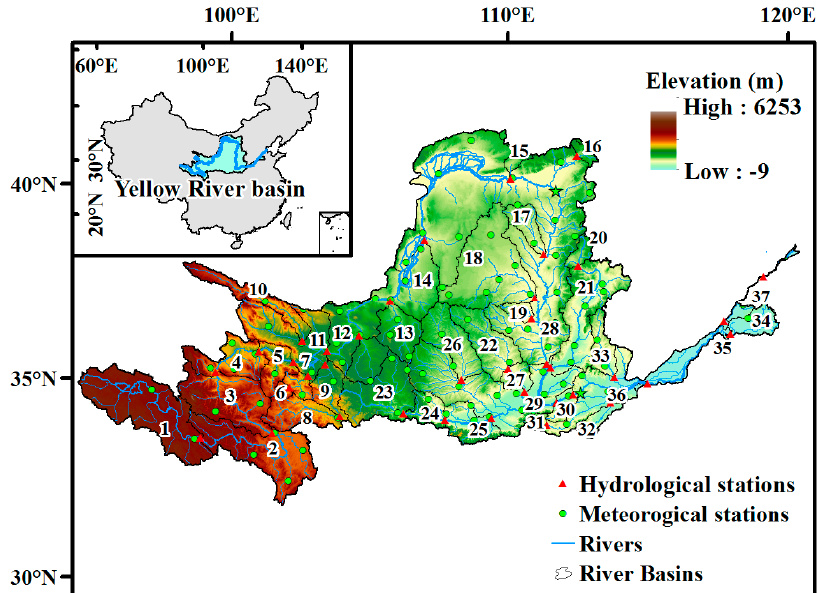
Figure 1. Locations of the 37 hydrological and meteorological stations in the Yellow River basin, China. The five ‐ point stars are the limits for the upper, middle, and lower reaches.